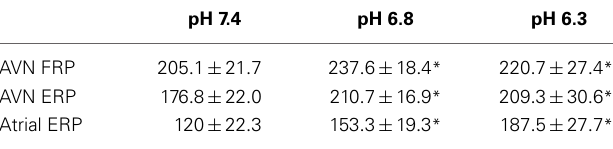
Table 3 | Effect of pH on atrial and AV nodal refractory characteristics.